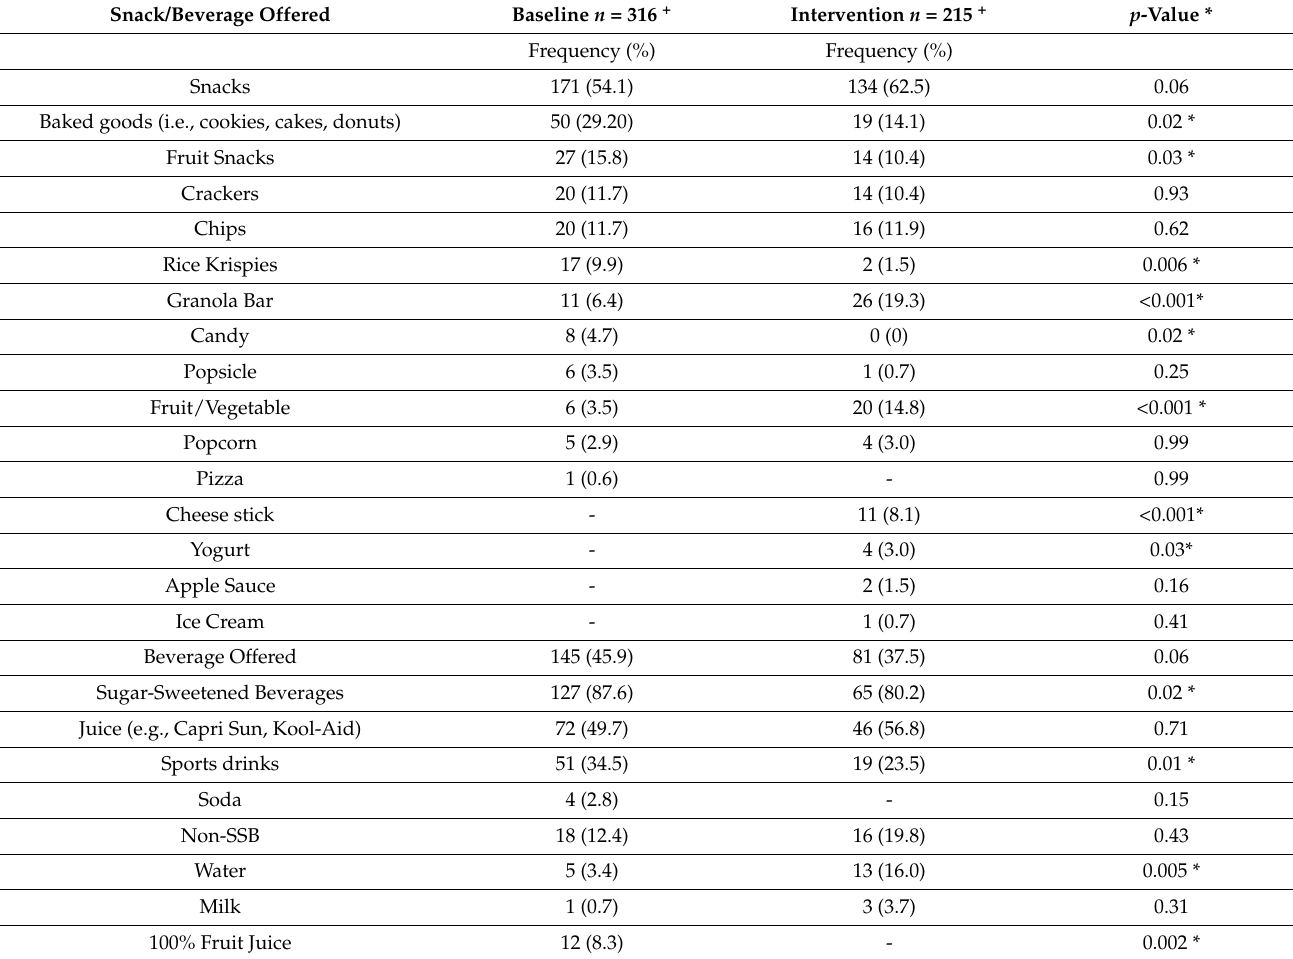
Table 4. Types of snacks and beverages offered during the season between baseline intervention to postintervention group. Snack/Beverage